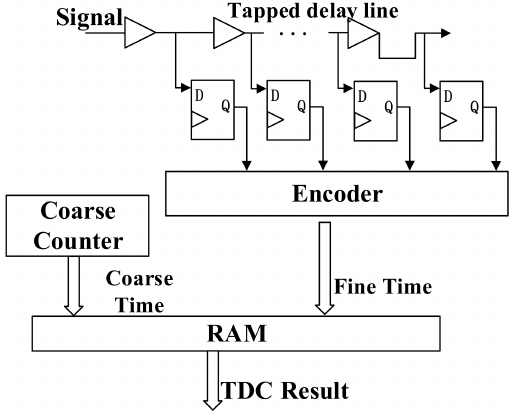
Figure 1. Block diagram of TDL-based TDC.